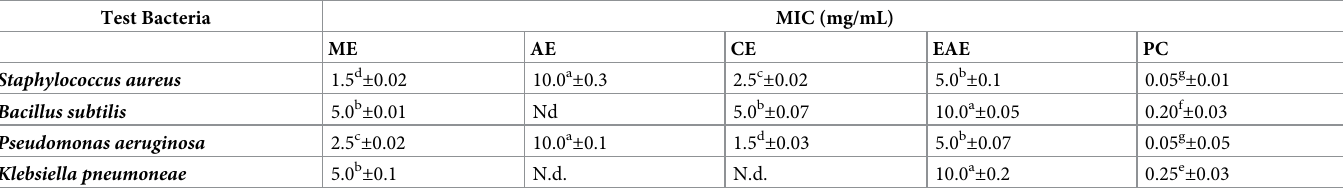
Table 6. MIC values for J . mimosifolia leaf extracts and fractions.